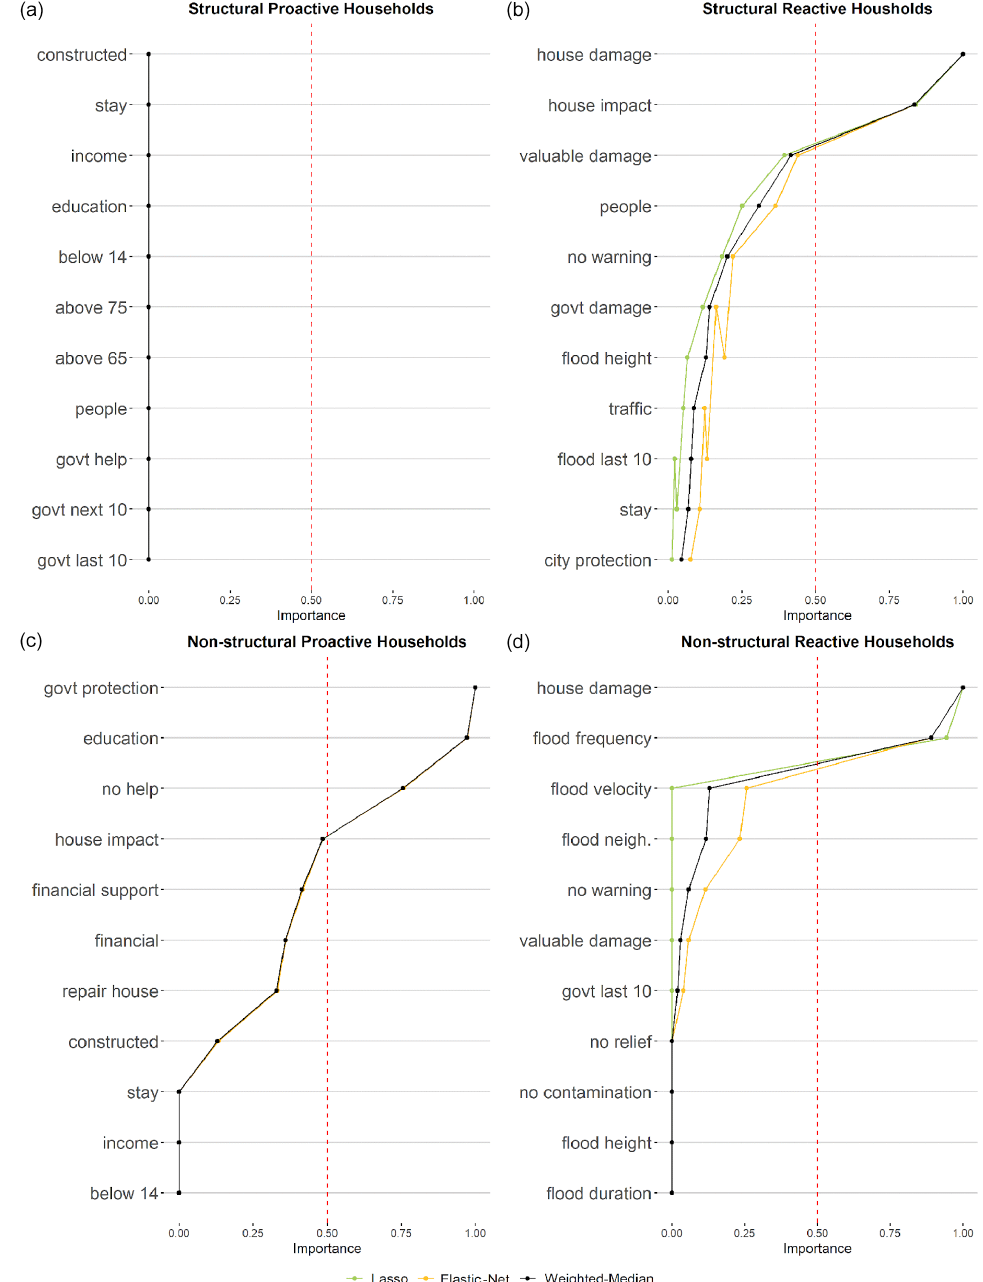
Figure 4. Drivers of private precautionary measures for (a) structural–proactive households, (b) structural–reactive households, (c) non- structural–proactive households and (d) non-structural–reactive households (variables on the y axis correspond to variable names in Ap- pendix